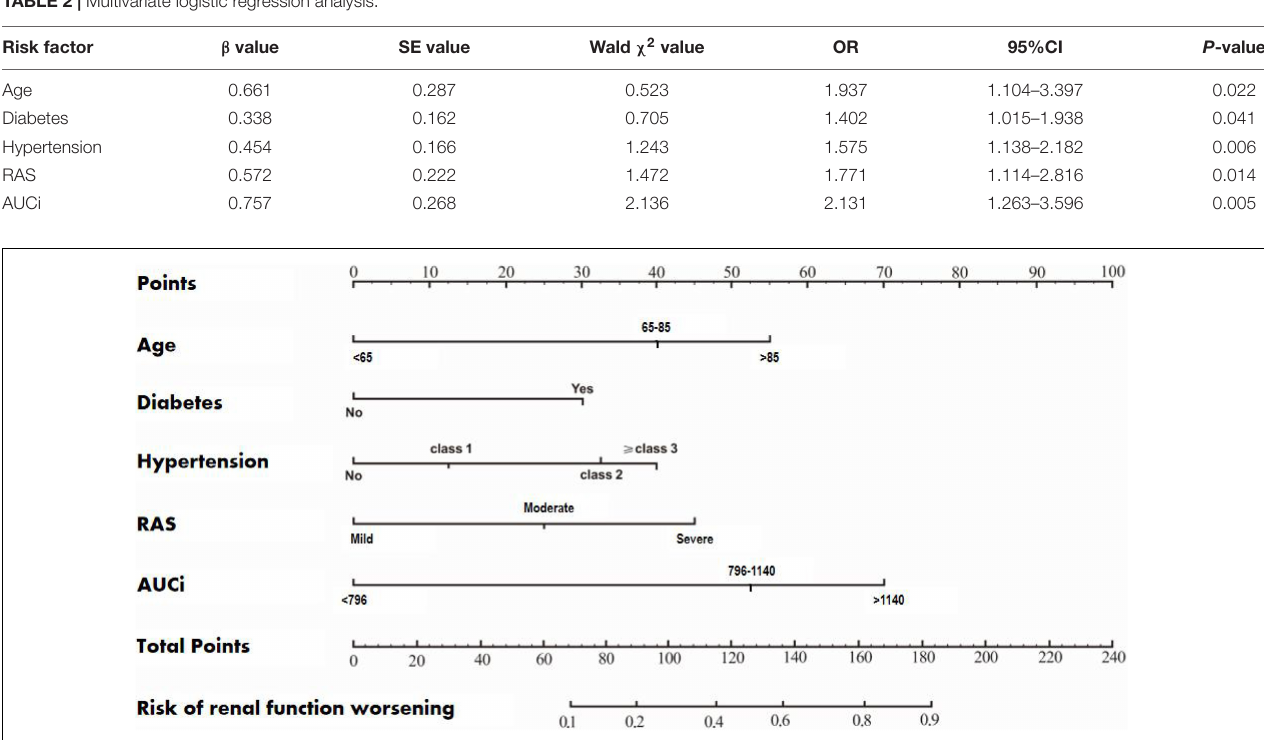
TABLE 2 | Multivariate logistic regression analysis.